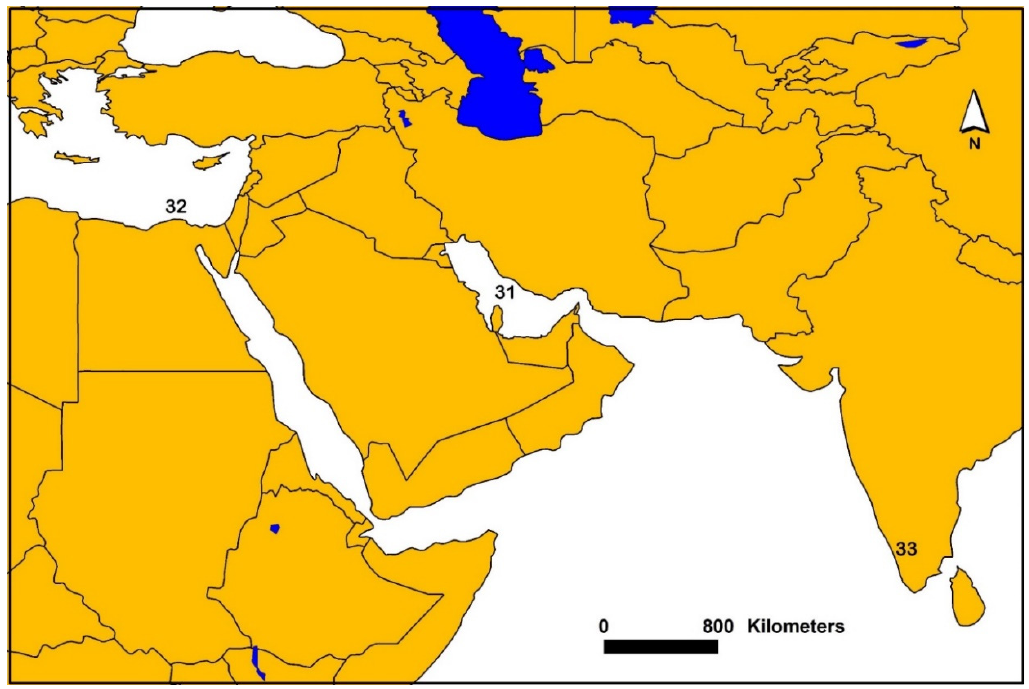
Figure 3. Map showing generalized locations where sediment AVS was sampled from various studies in Egypt, Iran and India. Number symbols on the map are associated with individual or multiple studies and references. The following numbers and associated references are: 31 [45], 32 [62,71] and 33 [66].